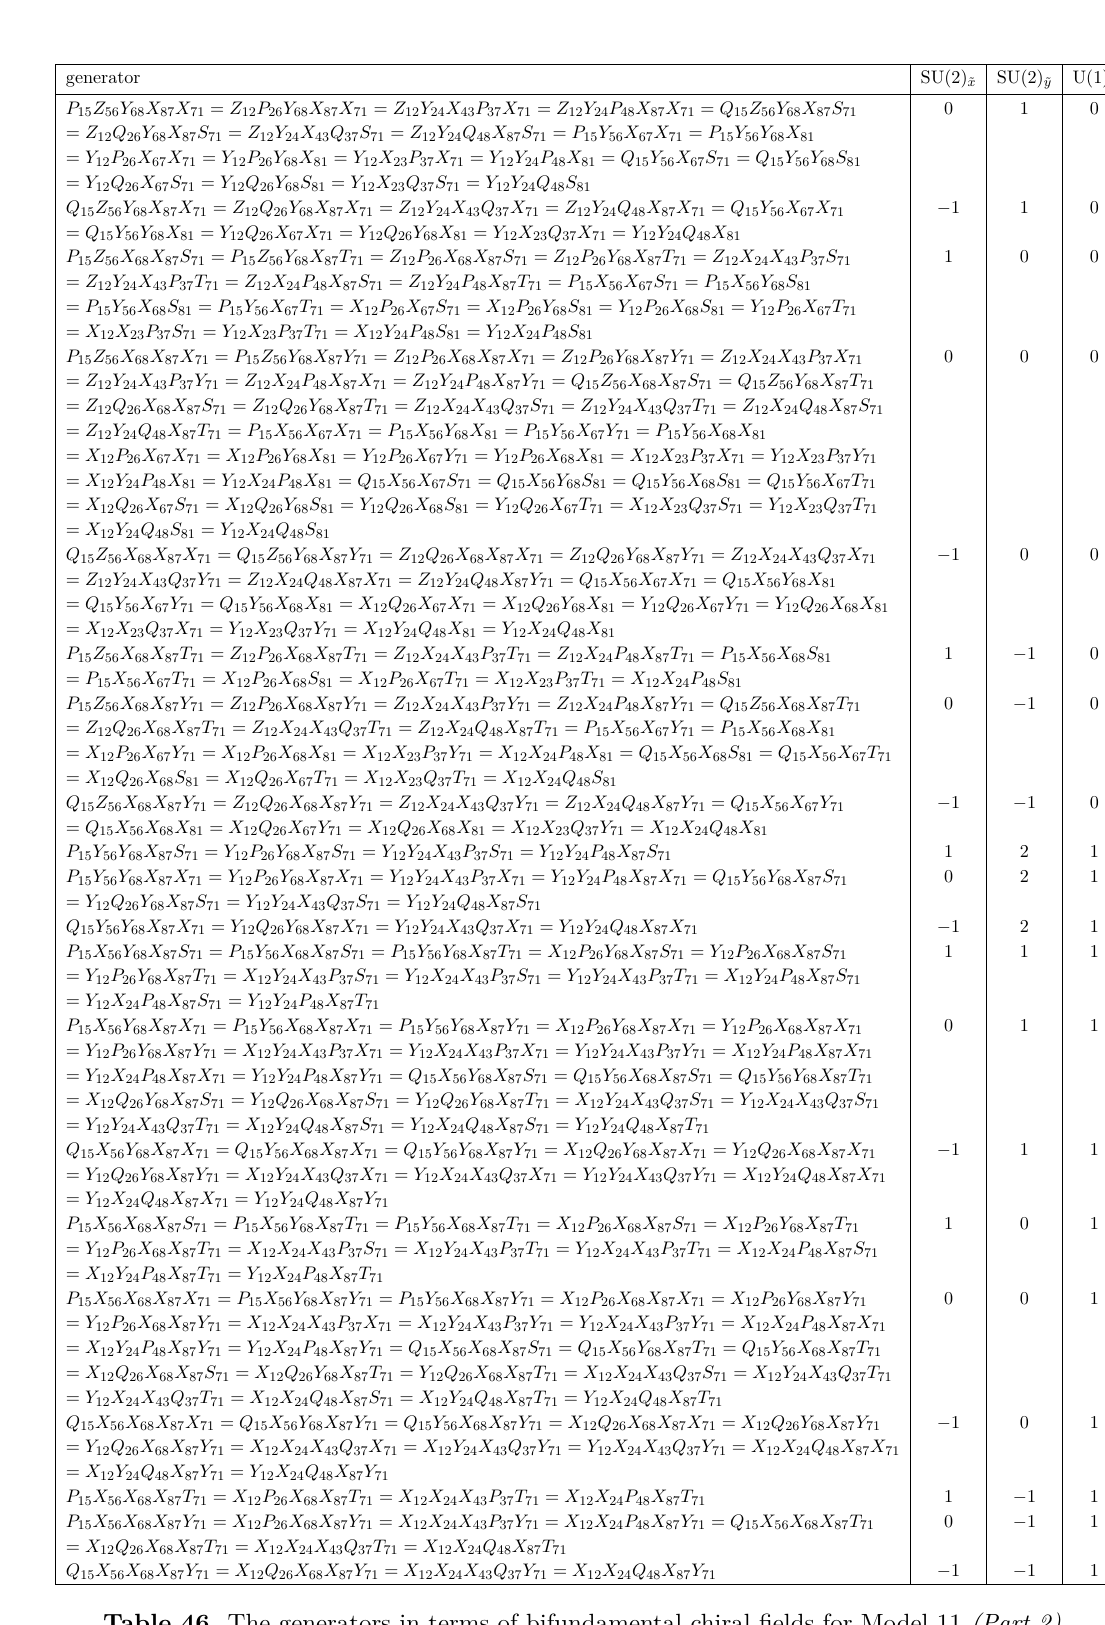
Table 46 . The generators in terms of bifundamental chiral fields for Model 11 (Part 2)